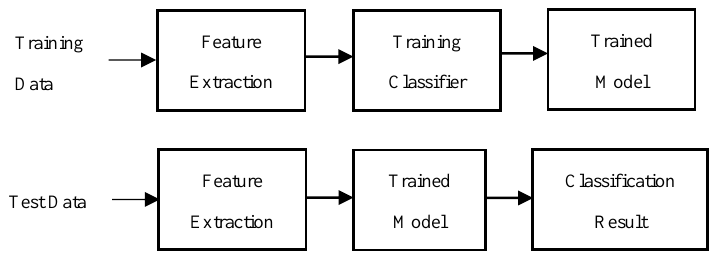
Figure 1. Basic methodology of classification task.